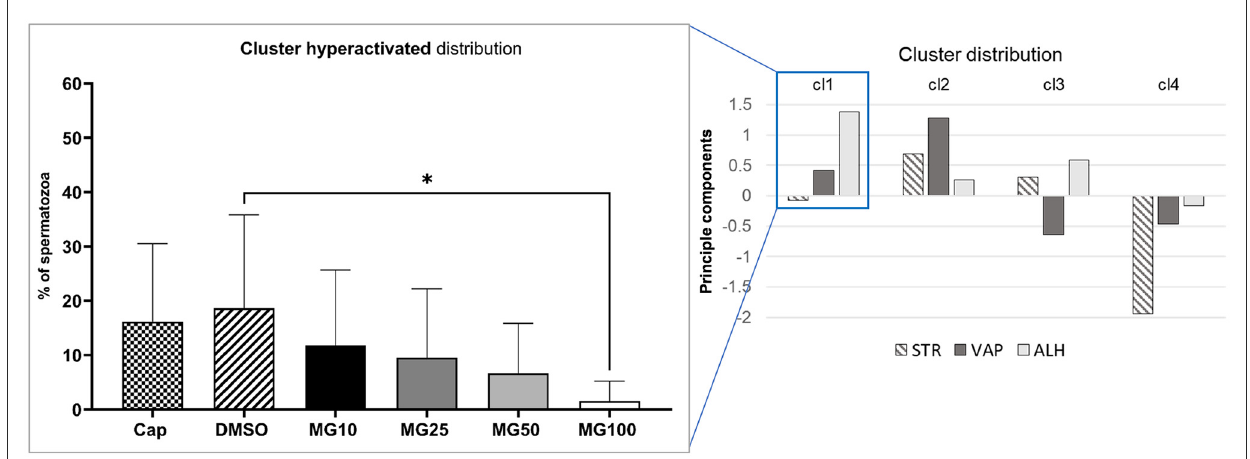
FIGURE3 Evaluation of hyperactivated sperm motility based on the cluster distribution of three kinematic parameters (STR, VAP, and ALH). Sperm kinematic parameters were measured during IVC under proteasomal inhibition by MG-132 at various concentrations (10, 25, 50, and 100 µ M), including capacitating (Cap) and vehicle (DMSO) controls. The right panel represents cluster identification based on cluster analysis coupled with PCA, followed by further data standardization. The left panel represents the effect of the MG-132 inhibitor on the hyperactivated cluster. Data are presented as mean ± SEM. Significance level * p ≤ 0.05.